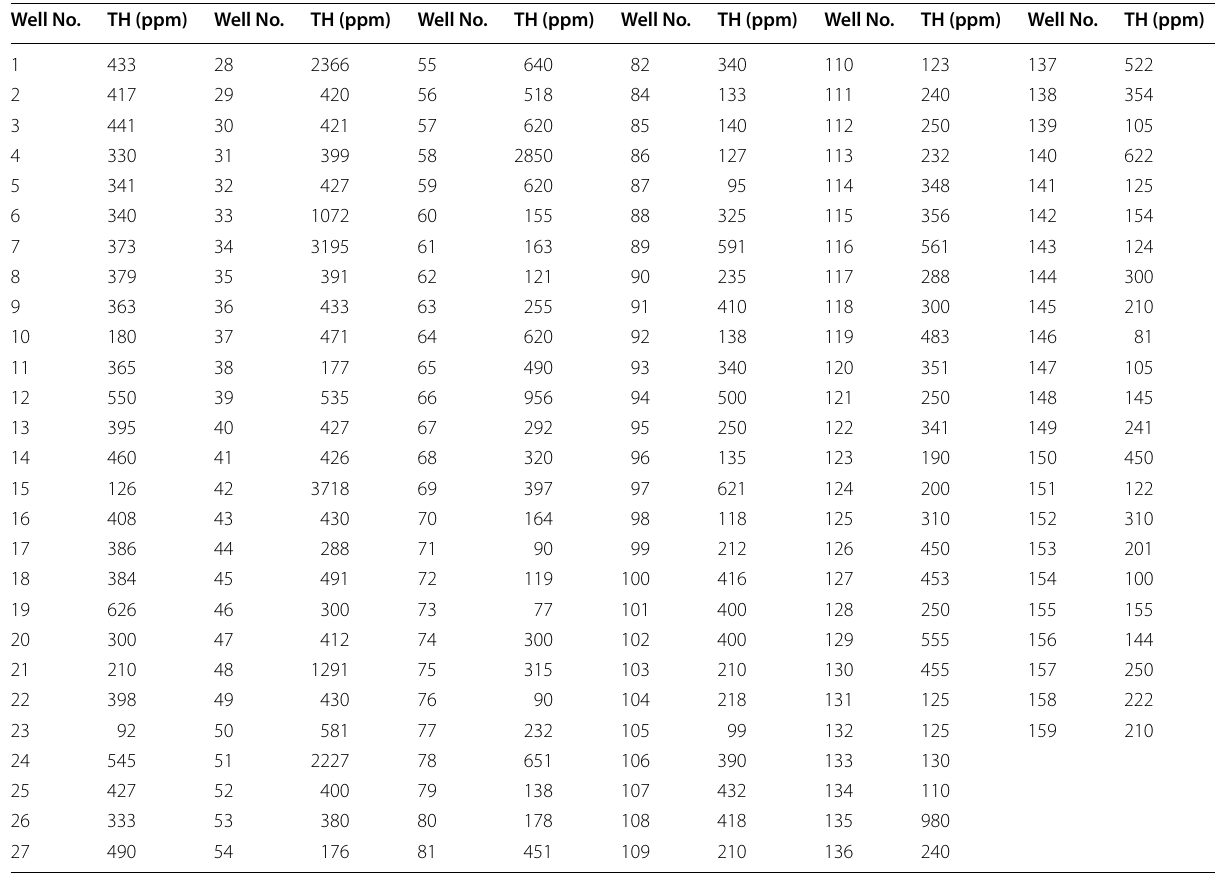
Table 3 Total hardness (TH) values of the groundwater samples in the area Well No.